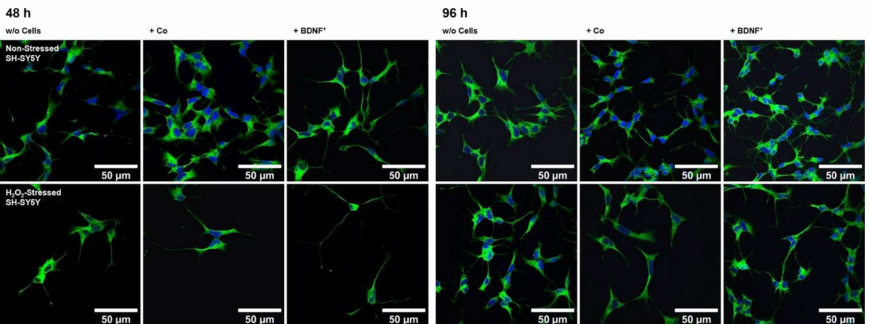
Figure 5. Neurite outgrowth in non-stressed and H 2 O 2 -stressed SH-SY5Y cells with or without co-cultivation of non-transfected and BDNF-transfected ARPE-19 cells. Representative confocal microscopy images of SH-SY5Y cells stained with neuron-specific beta-III tubulin antibodies (green) and DAPI (blue) are shown. Cells were cultivated for 48 or 96 h under the following conditions: non-stressed and H 2 O 2 -stressed SH-SY5Y alone (w/o Cells), non-stressed and H 2 O 2 -stressed SH- SY5Y with ARPE-19 cells (+ Co), non-stressed and H 2 O 2 -stressed SH-SY5Y with transfected ARPE- 19 cells (+ BDNF + , transfected with 0.03 µ g SB100X transposase and 0.47 µ g BDNF transposon plasmid). Number and length of neurites were analyzed using the Simple Neurite Tracer plugin from